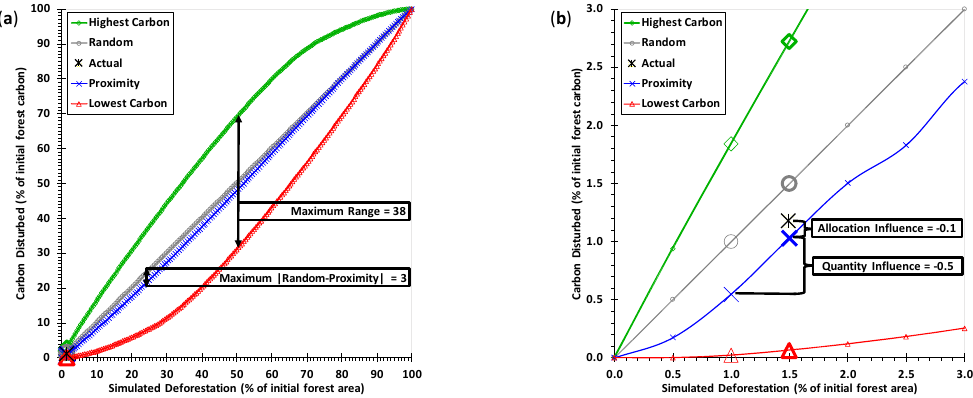
Figure 7. Carbon disturbed versus deforestation quantity at ( a ) full range and ( b ) zoomed in.